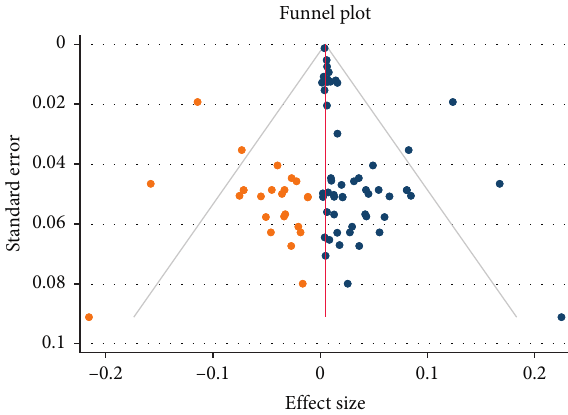
Figure 4: Trim and fill analysis of anti-HCV prevalence studies in Ethiopia published from 2010 to